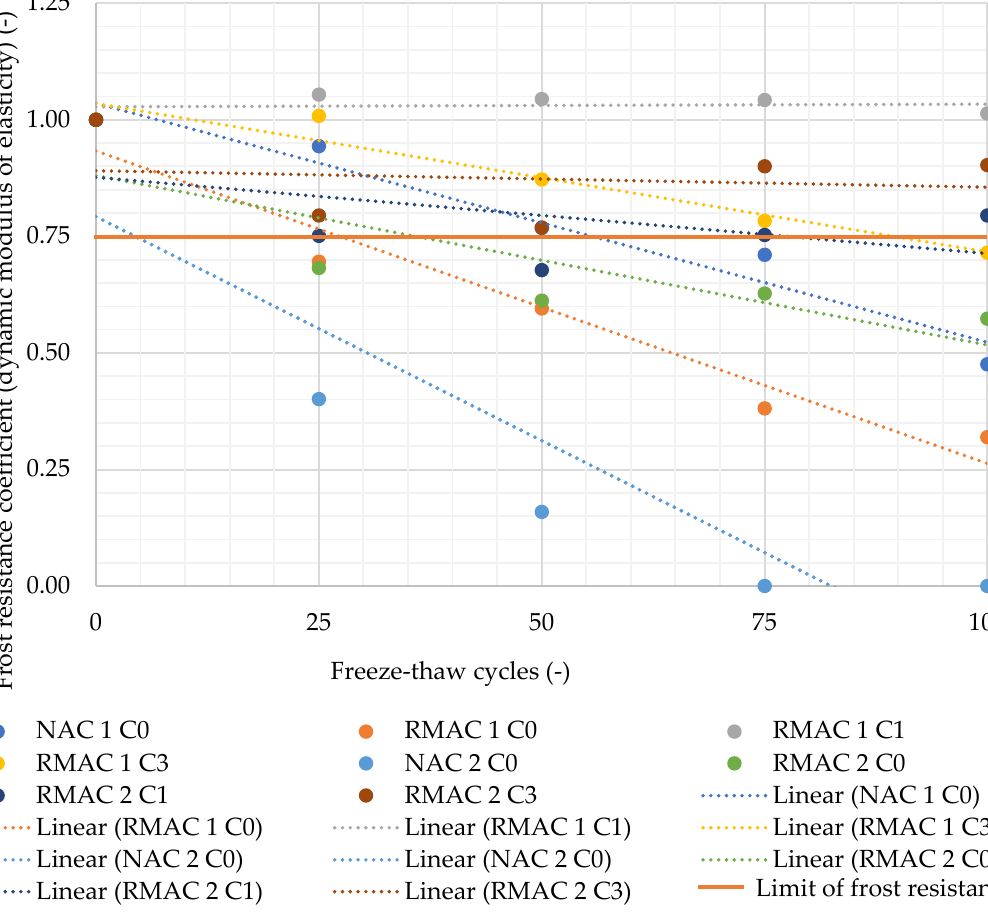
Figure 5. Frost resistance coe ffi cient determined from the dynamic modulus of elasticity. Table 6. Flexural strength and frost resistance coe ffi cient determined from flexural strength after freezing and thawing